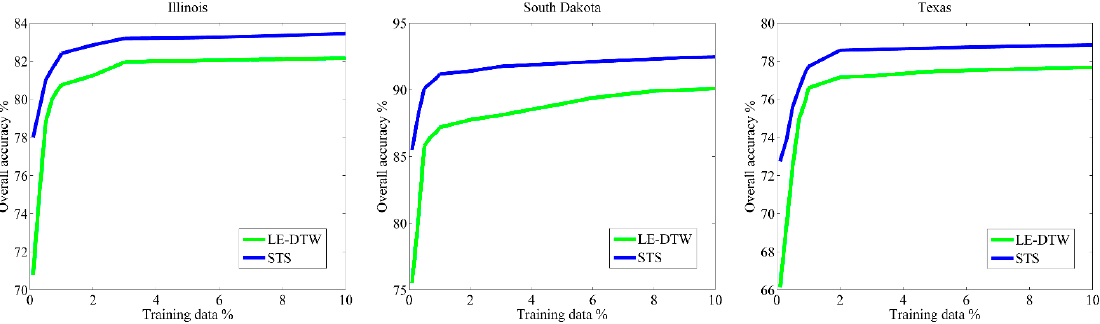
Figure 11. Sensitivity to the different training data percentage (0.1%, 0.3%, 0.5%, 0.7%, 0.9%, 1%, 2%, 3%, 4%, 5%, 6%, 7%, 8%, 9% and 10%). At each percentage on three study areas, the mean overall accuracies of the LE-DTW (green) and STS (blue) calculated by 10 independent classifications are shown.